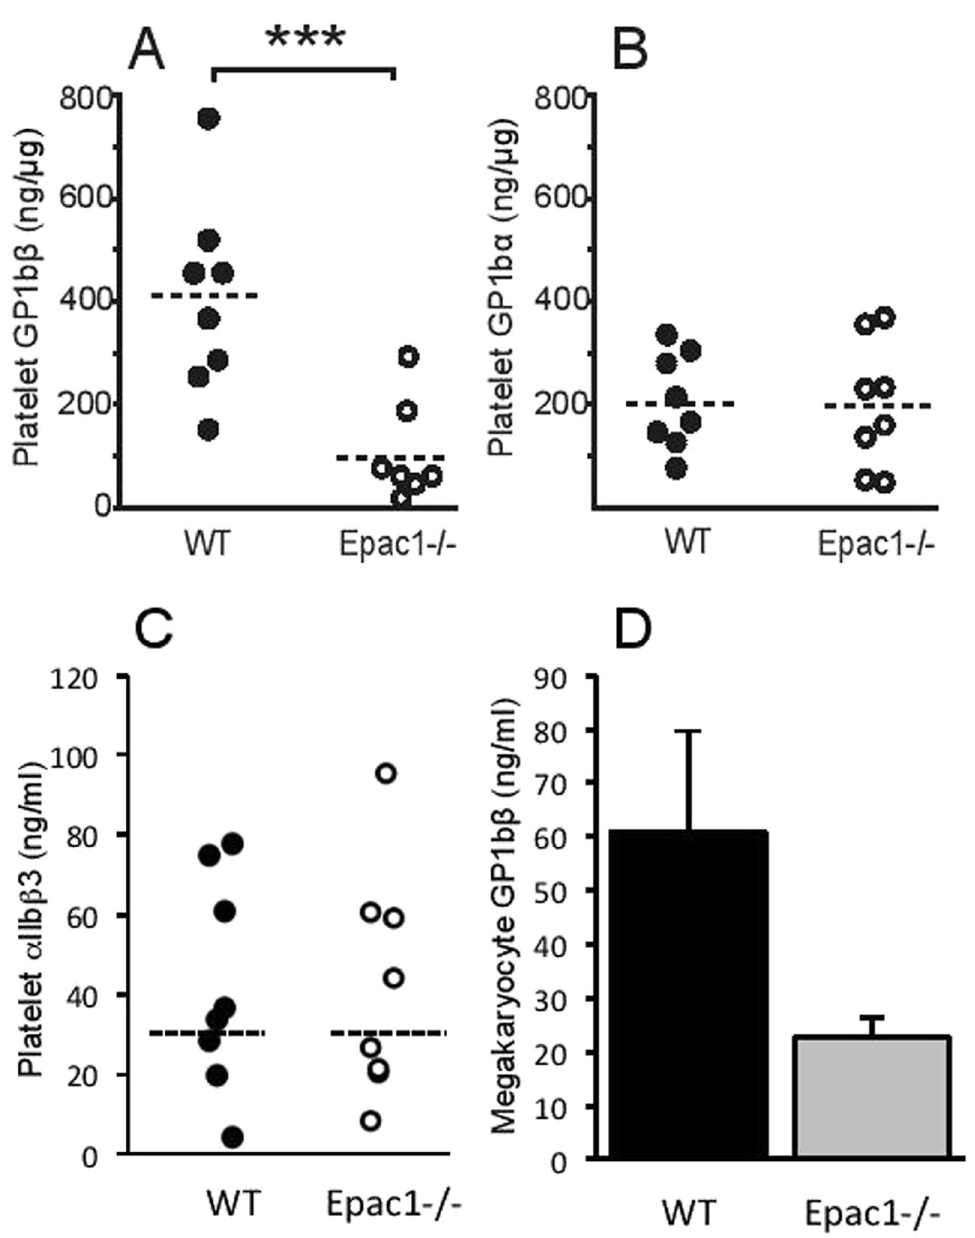
Figure 6. Decreased platelet levels of GP1b β and un-altered levels of GP1b α in Epac1 − / − mice. Quantification of GP1b β ( A ), GP1b α ( B ) and α IIb β 3 ( C ) of platelets from WT (n = 8) and Epac1 − / − (n = 8) mice by ELISA. Each dot represents the data from a single mouse. ( D ) Quantification of megakaryocyte GP1b β by ELISA from WT (n = 3) and Epac1 − / − (n = 3) mice. The horizontal dashed lines represent the mean. *** P <